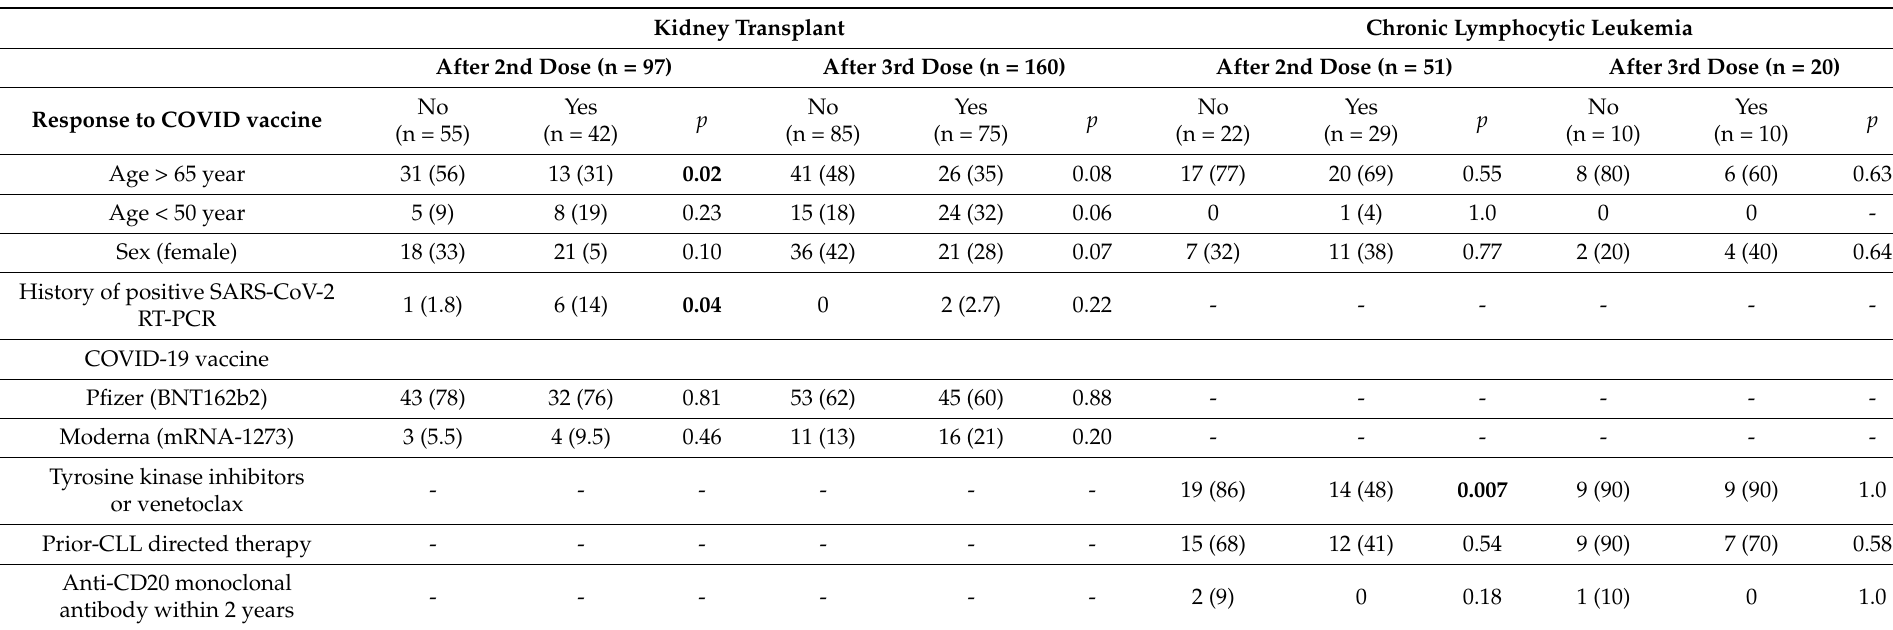
Table 1. Factors associated with response to COVID-19 vaccines in 245 kidney transplant recipients and 51 patients treated for chronic lymphocytic leukemia. Kidney Transplant After 2nd Dose (n =